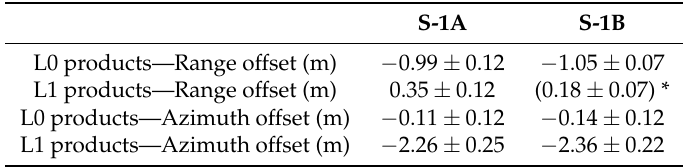
Table 3. Mean value and standard deviation ( µ ± σ ) for estimated range and azimuth offset using L0 data with the proposed method and L1 products for both S-1A and S-1B. Note that, for the S-1B range offset using L1 products, the outliers from Stripmap beam S1 are excluded (*). S-1A